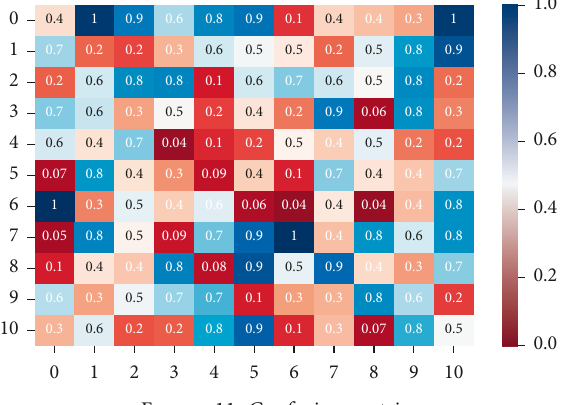
Figure 11: Confusion